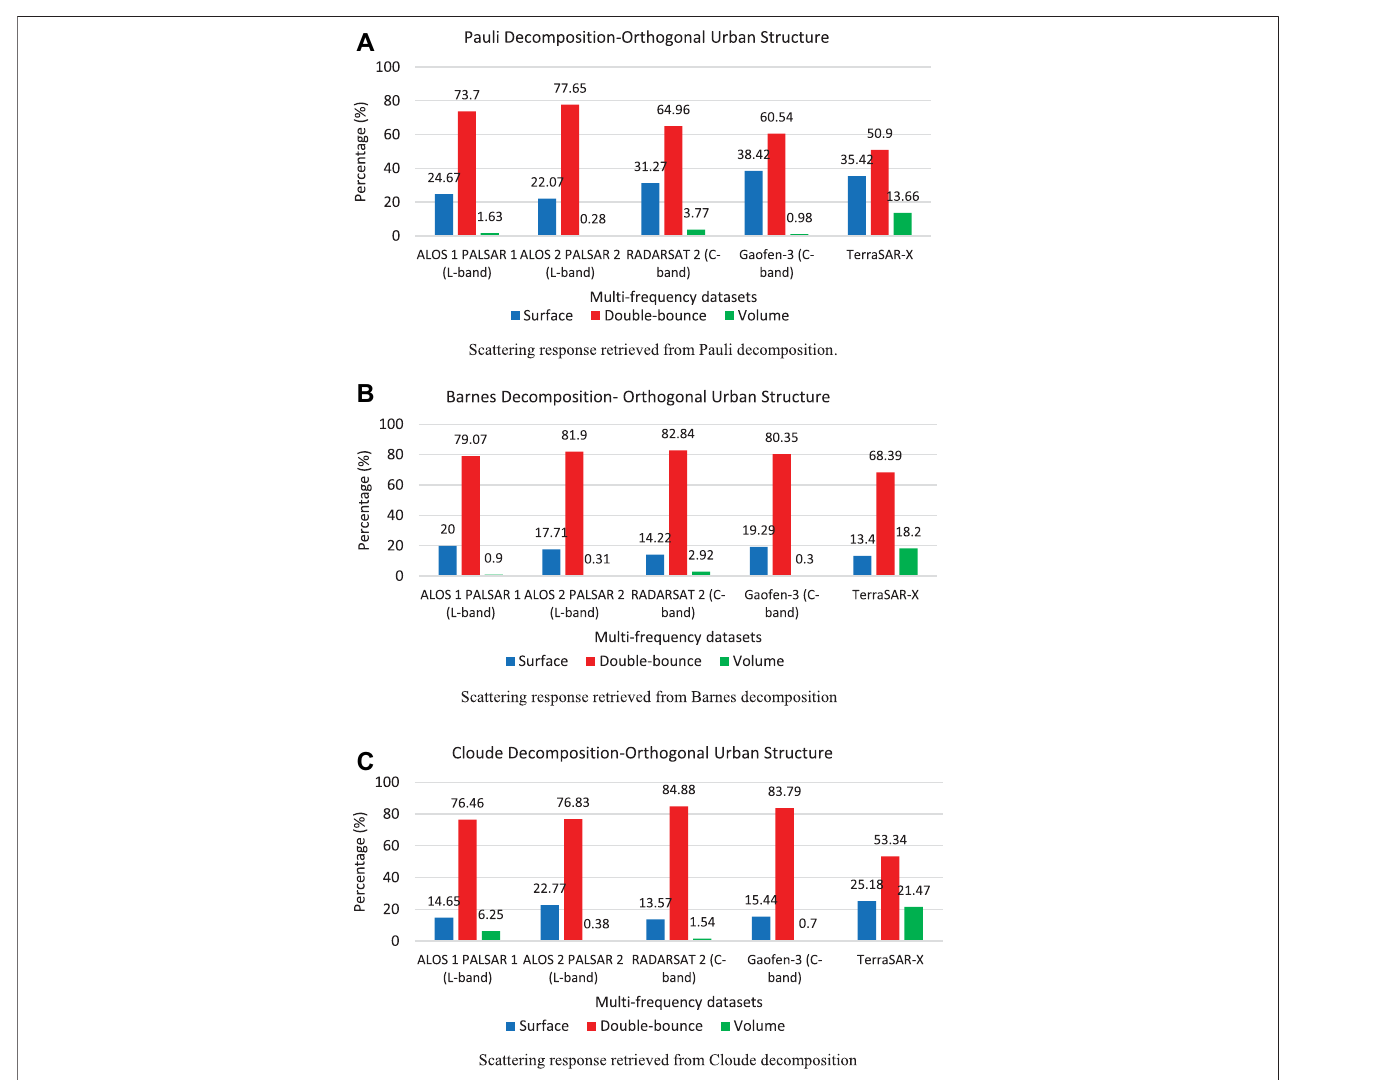
FIGURE 7 | Backscattering response for orthogonal urban structure obtained from Pauli, Barnes, and Cloude decomposition models. (A) Scattering response retrieved from Pauli decomposition. (B) Scattering response retrieved from Barnes decomposition. (C) Scattering response retrieved from Cloude decomposition.